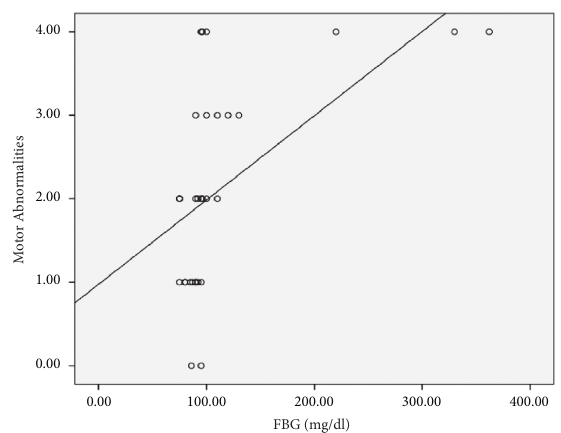
Figure 6: Scatter plot between motor abnormalities and FBG. Table 5: Logistic regression analysis of factors affecting of UPDRS in parkinsonian